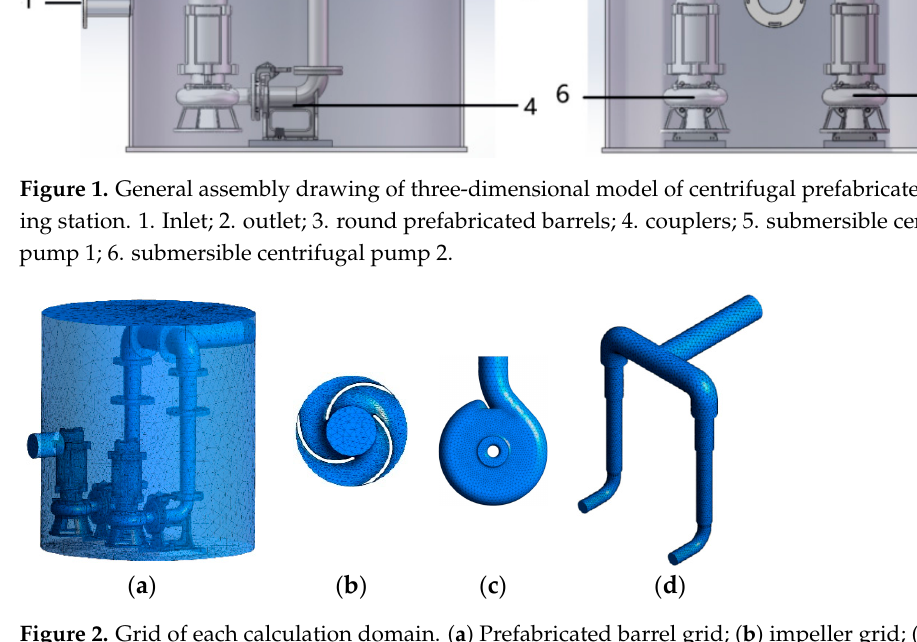
Figure 1. General assembly drawing of three-dimensional model of centrifugal prefabricated pump- ing station. 1. Inlet; 2. outlet; 3. round prefabricated barrels; 4. couplers; 5. submersible centrifugal pump 1; 6. submersible centrifugal pump 2.